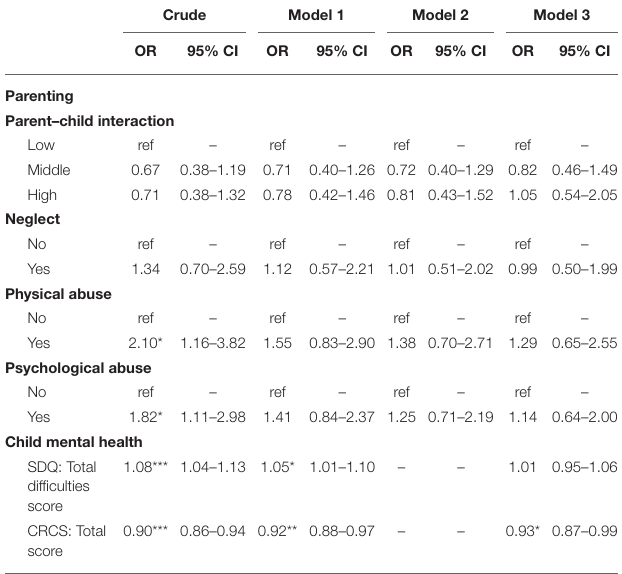
TABLE 3 | Association between parenting in the first grade and school refusal in the second grade after multiple imputation.